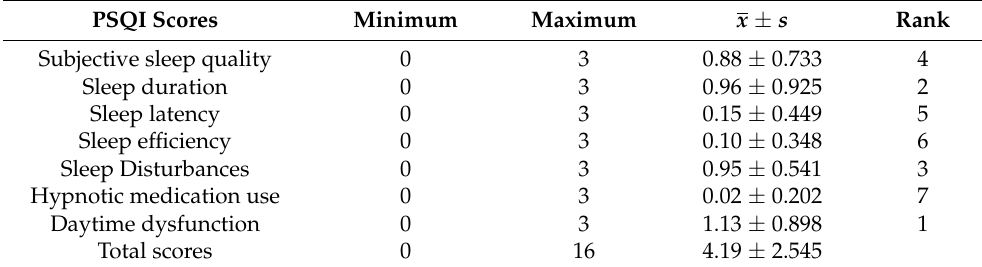
Table 2. PSQI total score and score details of each factor.